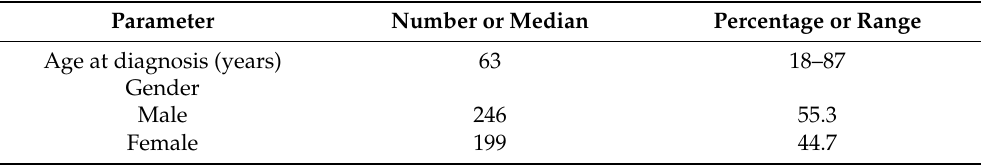
Table 1. Patient characteristics .